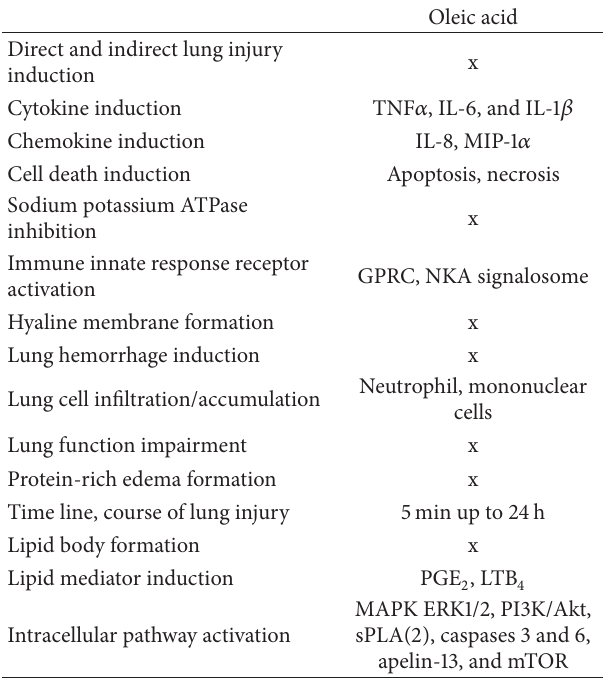
Table 3: Key features of oleic acid-triggered lung injury and